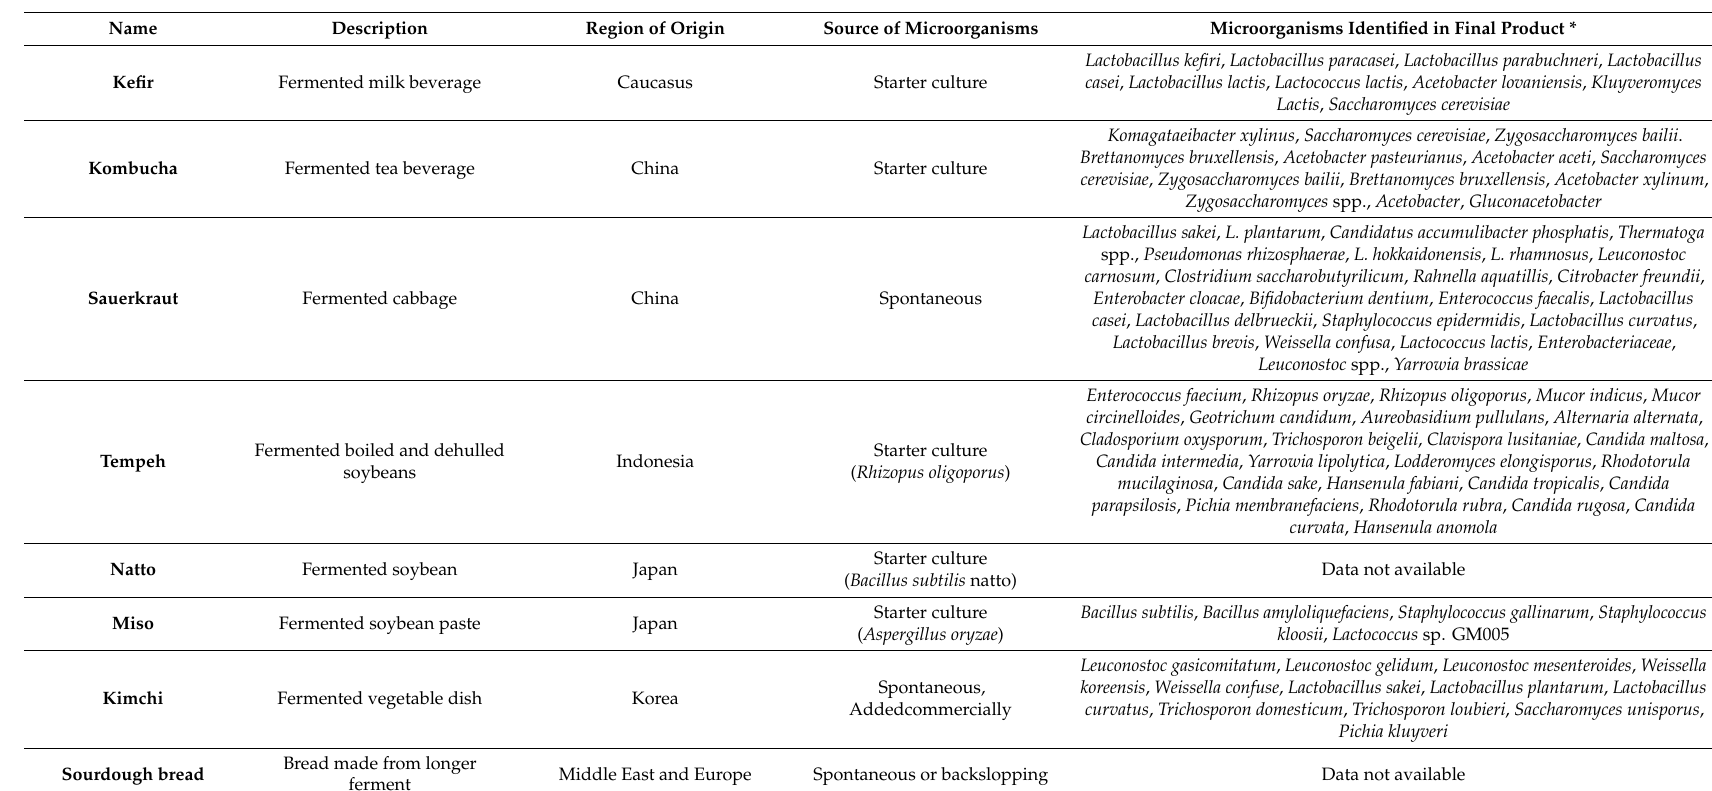
Table 1. Description and microbial content of common fermented